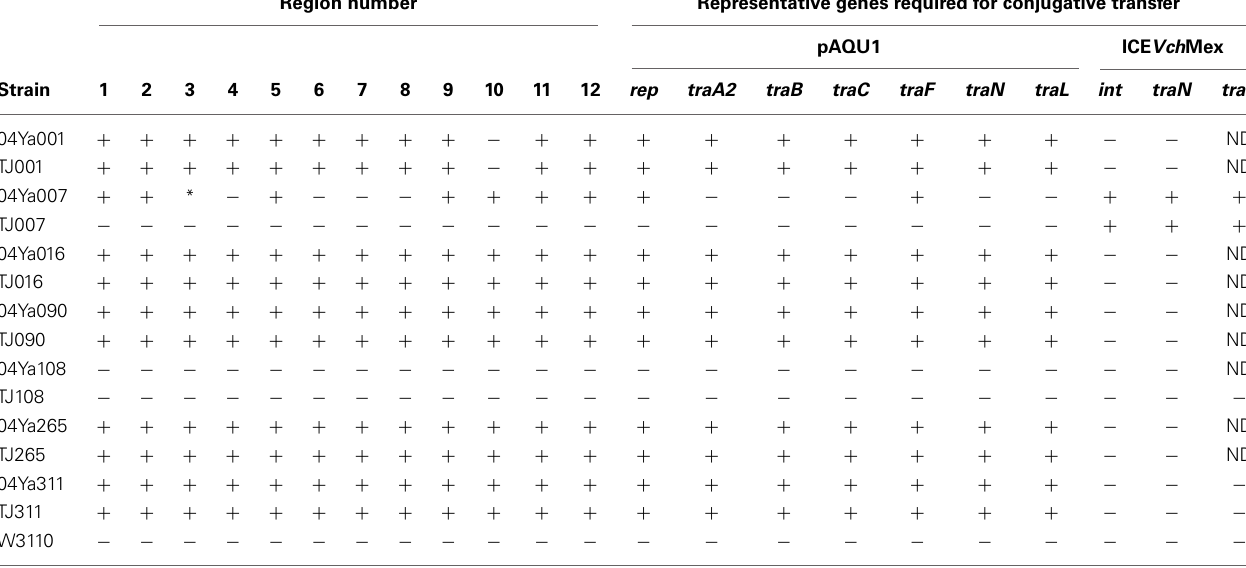
Table 6 | Detection of the conserved region (pAQU backbone) and tra genes specific for pAQU1 and ICE Vch Mex in donors and transconjugants by